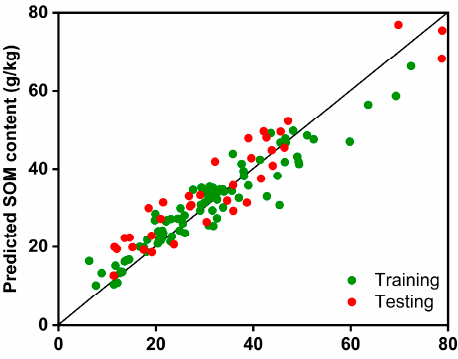
Figure 10. The prediction results of PLSR model established by GA-BP algorithm.